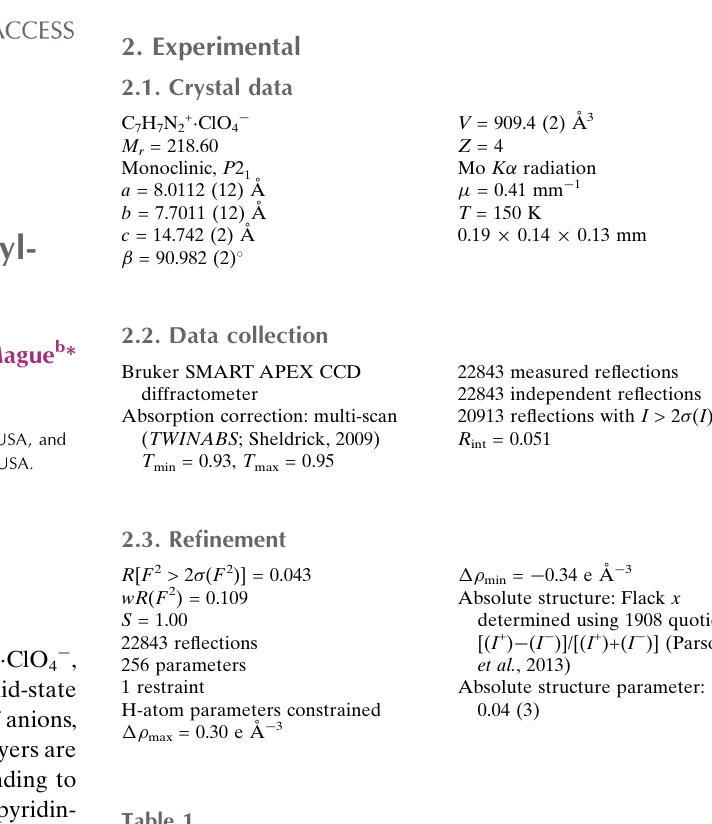
Hydrogen-bond geometry (A˚ , (cid:4)